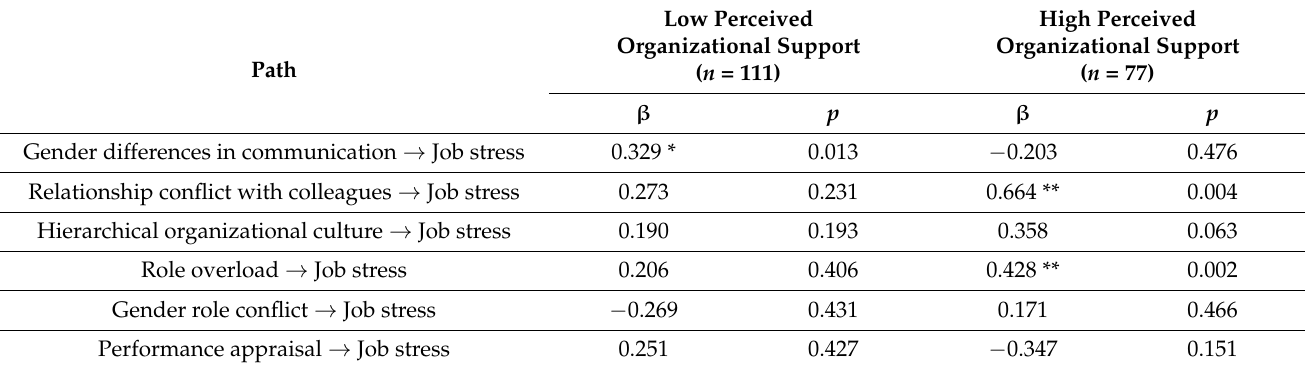
Table 10. Moderating effect of perceived organizational support on job